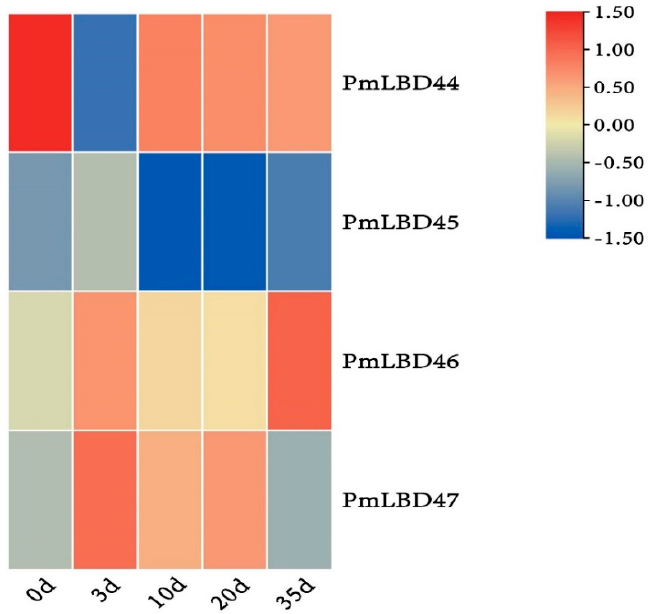
Figure 6. Transcription products of the LBD gene at different stages during inoculation with P. massoniana nematodes: days 0, 3, 10, 20 and 35. Heat maps were generated using log2 (FPKM+1) values and then line scales were executed. Dark blue indicates low expression levels, light colors indicate moderate expression levels, and red indicates high expression levels.